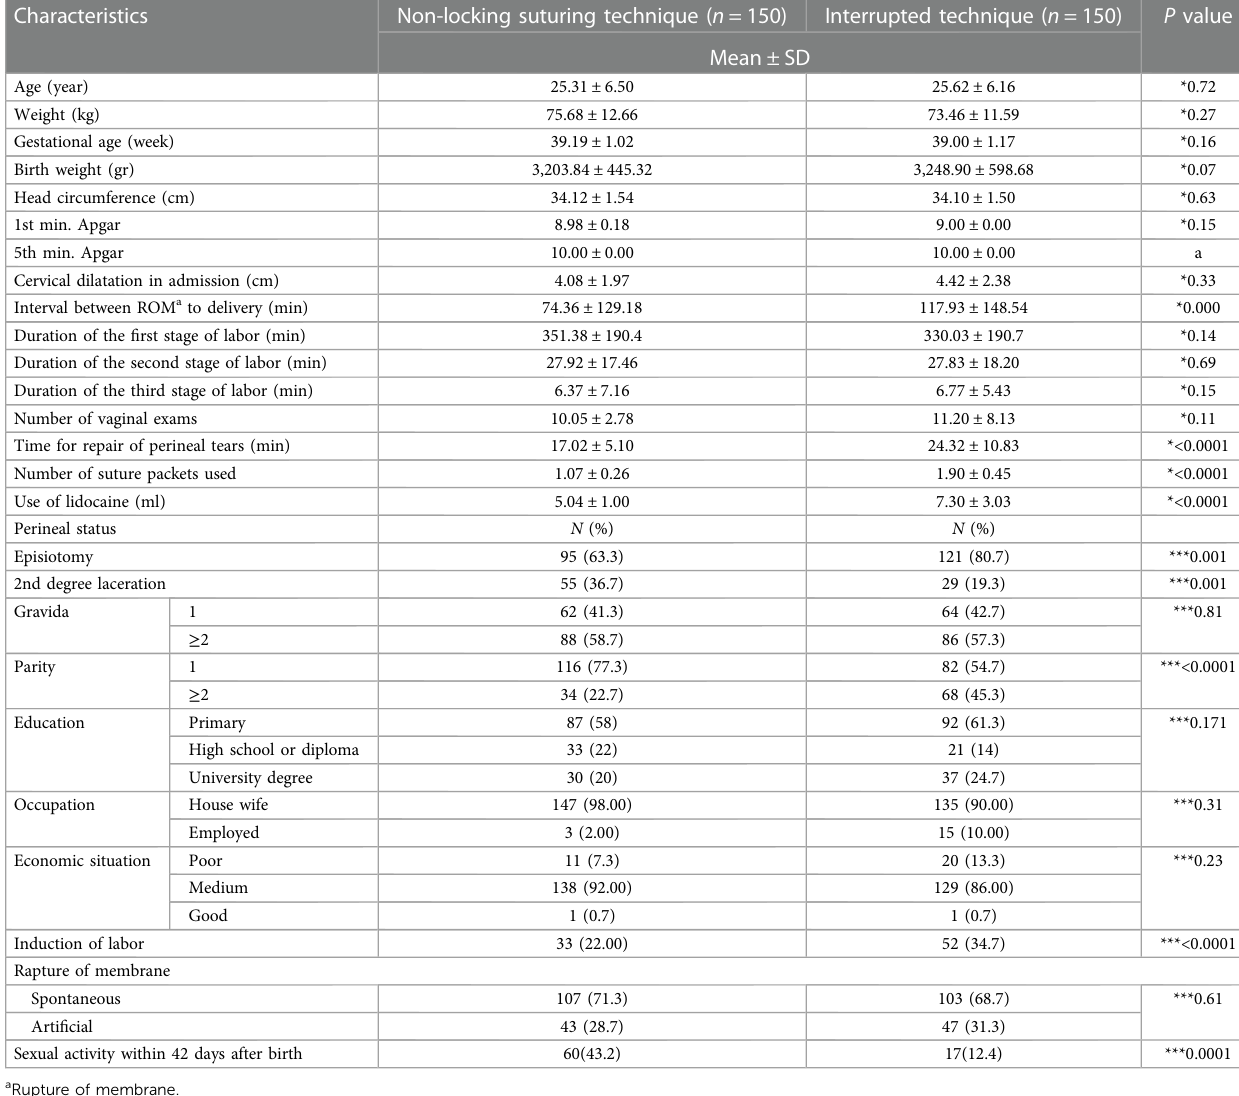
TABLE 1 The sociodemographic and obstetric characteristics of participants in two groups of non-locking suturing technique and interrupted technique.